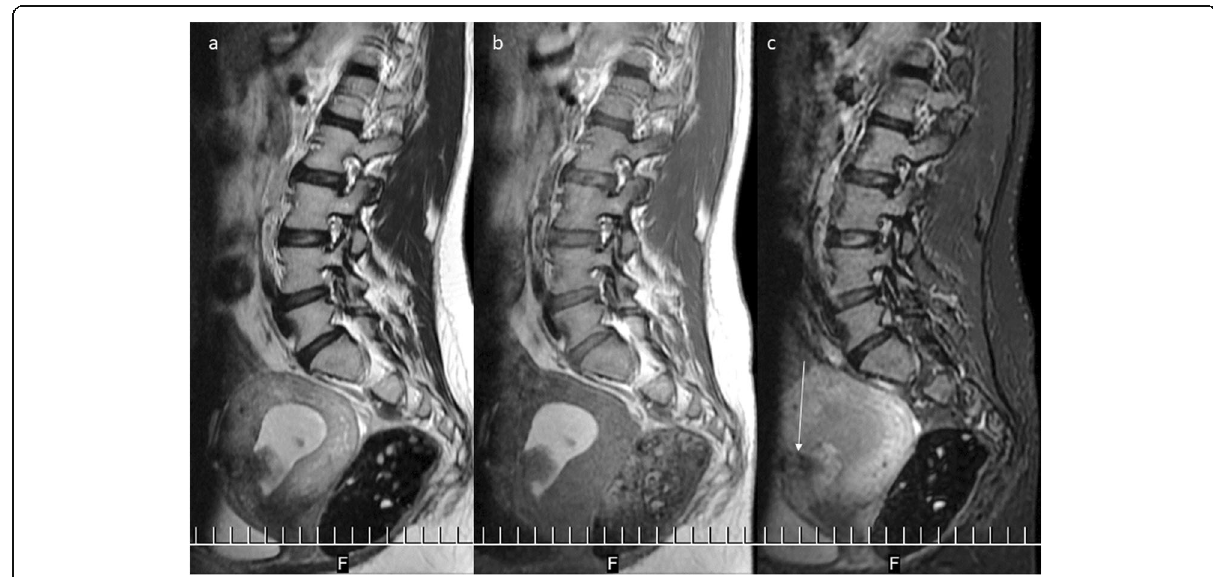
Fig. 3 MRI of the lumbar-sacral part of the vertebral column in the sagittal plane. a FSE/T2WI. b FSE/T1WI. c STIR image. The study performed for neurological indications 2 weeks after C-section shows the forming scar in the anterior uterine wall, best appreciated as a thick hypointense band on STIR ( c arrow). Blood (hyperintense on T1WI and T2WI, suppressed on STIR) and clot (T1- and T2-hypointense, slightly hyperintense on STIR) in